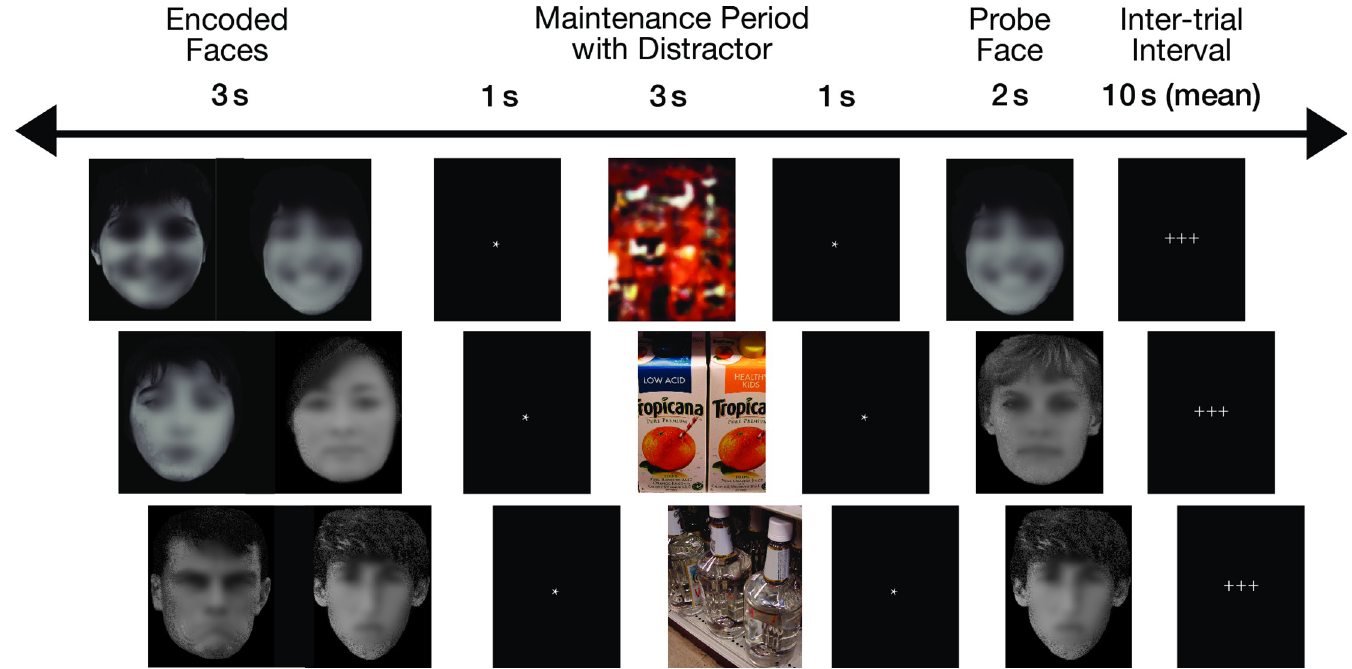
Fig 1. Task presented during functional neuroimaging. Two faces were presented simultaneously for 3 seconds, followed by an asterisk for one second. Next, a distractor was presented for 3 seconds, followed by an asterisk for 1 second. The probe face immediately followed, during which the subjects had been trained to respond with a button press with either their index or middle finger to indicate whether the probe face matched the encoded face. Three crosses served as the fixation stimulus and inter-trial interval, which lasted from 2 to 22 seconds (mean 10 seconds). The faces in this figure have been blurred to mask the identities of the individuals, but the research participants saw the original unblurred